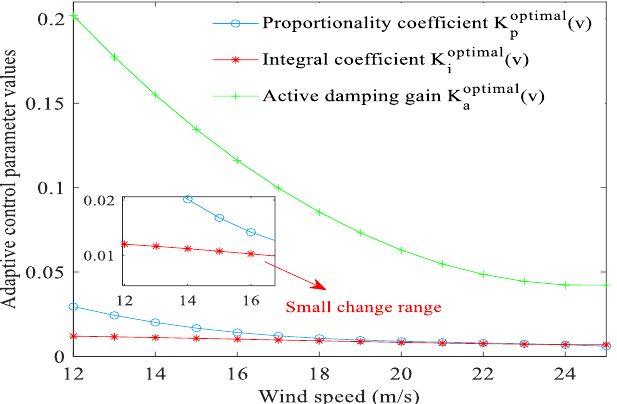
Figure 8. The designed for adaptive control.